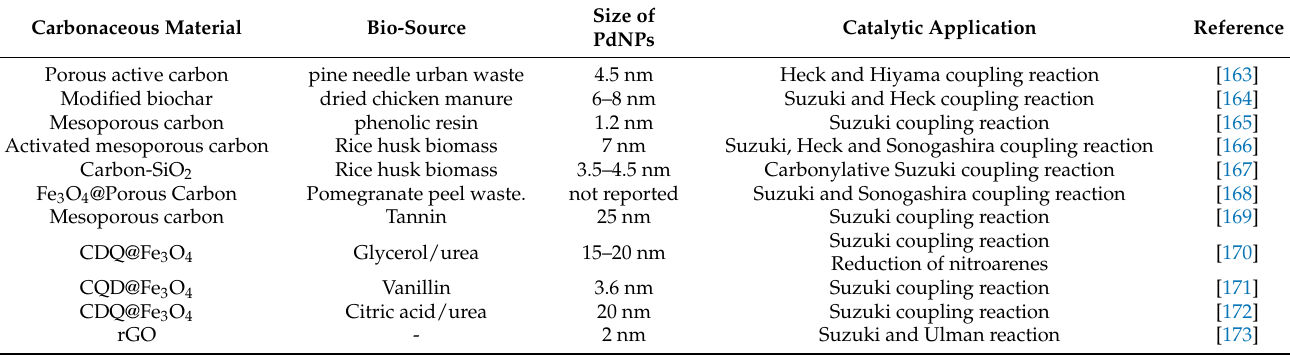
Table 5. Green synthesis of supported PdNPs on carbonaceous materials and their applications. Carbonaceous